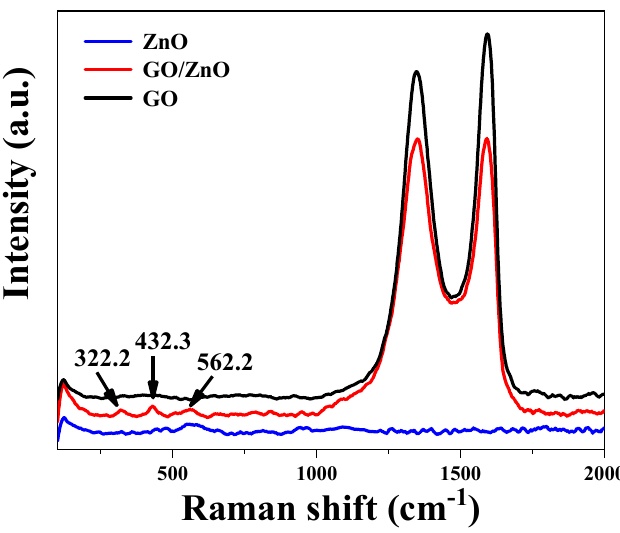
Figure 5. Raman spectra of pure GO, porous single-crystal ZnO nanosheets and GO/ZnO nanosheet composites.